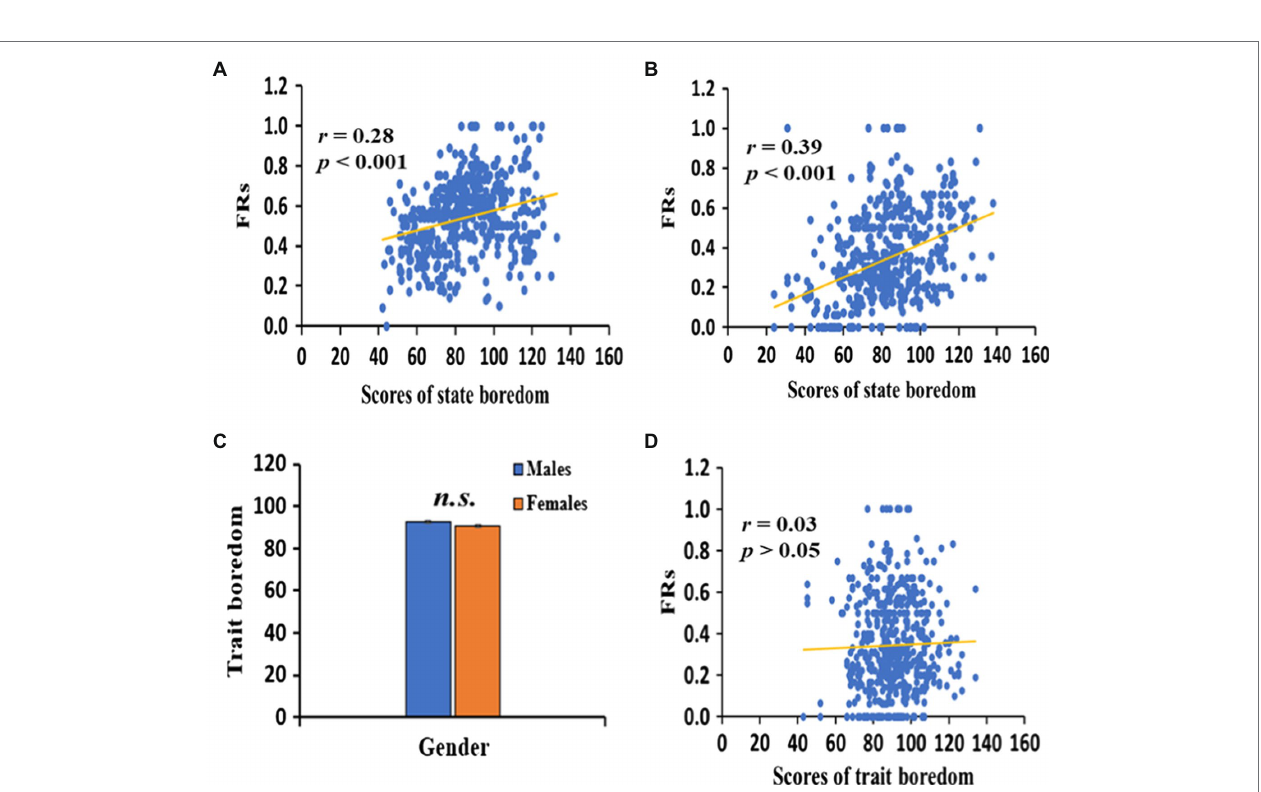
FIGURE 3 | Correlation between FRs and scores of state boredom in Experiment 1 (A) and Experiment 2 (B) . Gender difference for scores of trait boredom (C) and correlation between FRs and scores of trait boredom (D) in Experiment 1. n.s. means no